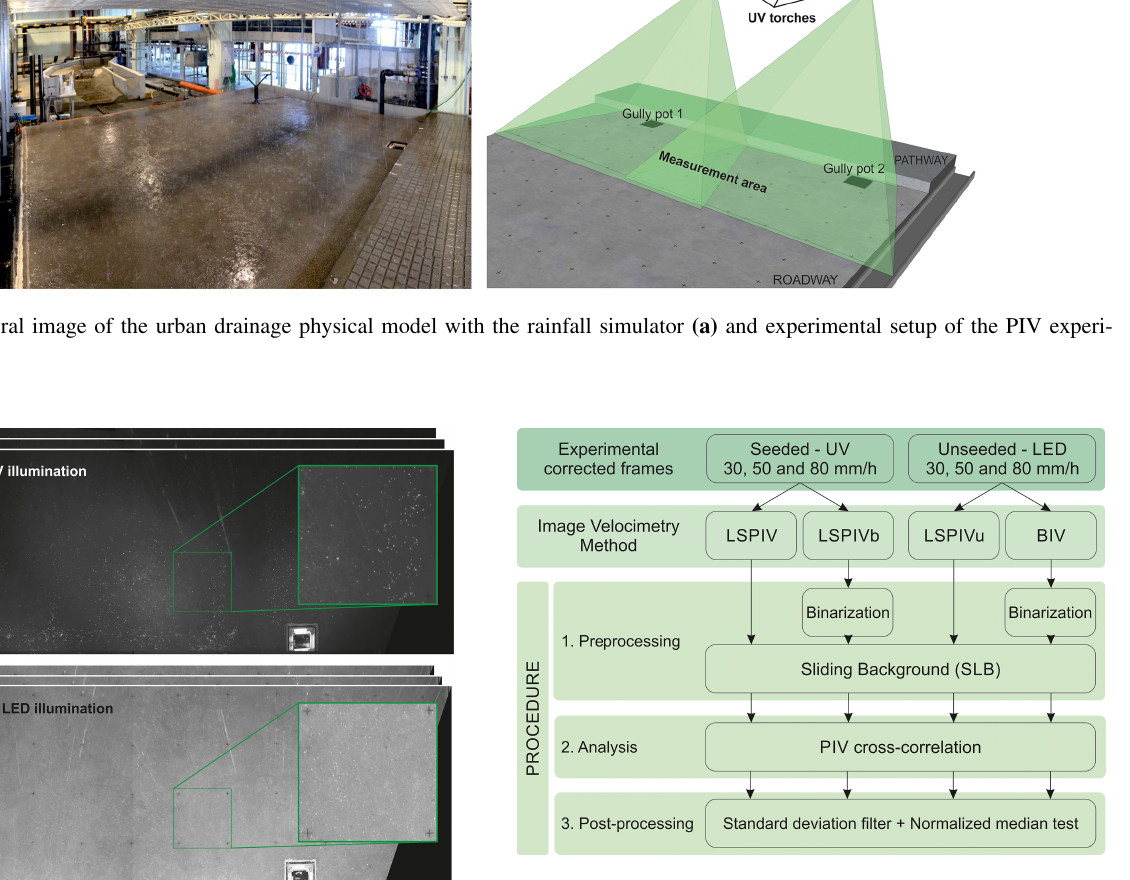
Figure 3. Diagram of the procedure performed to obtain velocity fields from video frames for the different image velocimetry tech-